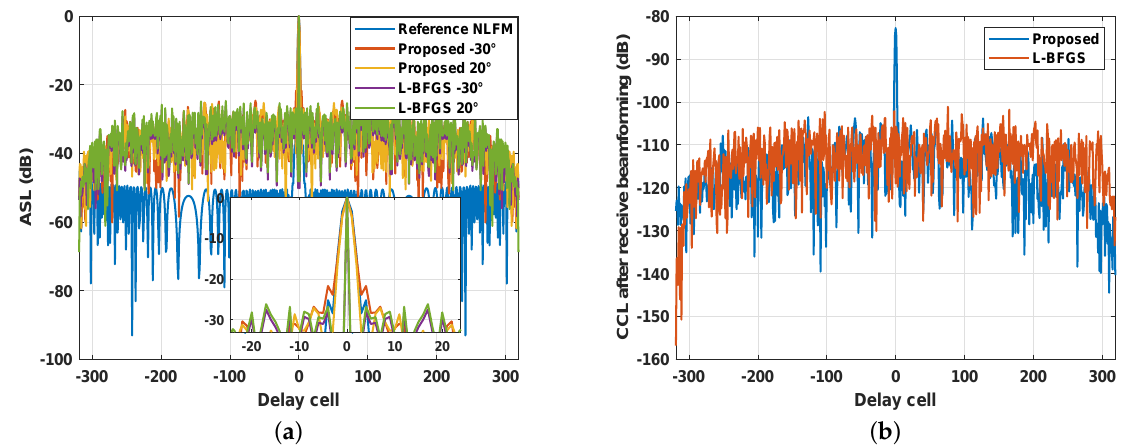
Figure 15. The result of the proposed method and the L-BFGS after receive beamforming. ( a ) The ASL of AWs. ( b ) The CCL of AW at − 30 ◦ after receive beamforming.